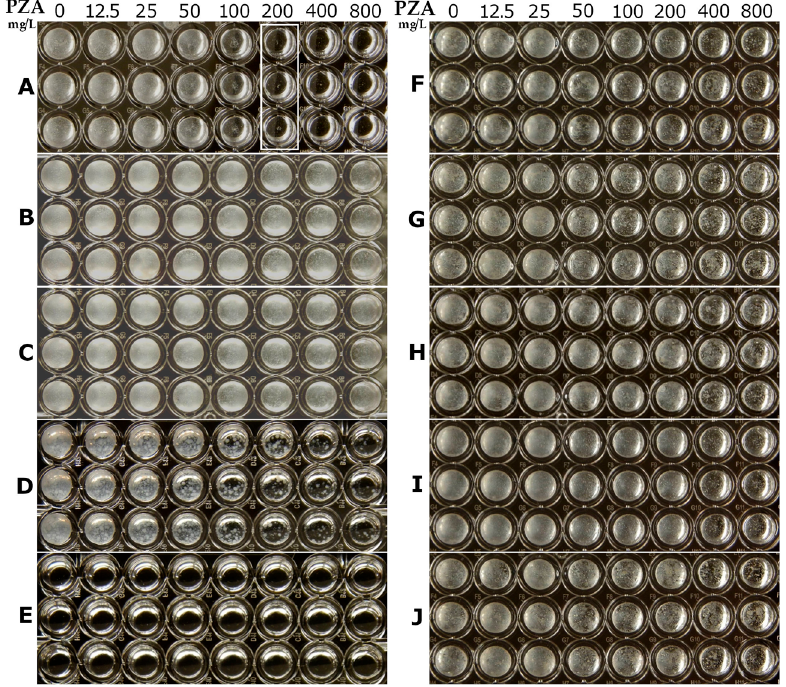
Figure 2. Determination of MIC of PZA against different M. tuberculosis strains using the broth microdilution method. ( A ), M. tuberculosis H37Ra, PZA-susceptible strain at pH 6.8 in PZA-S1 minimal medium; ( B ), M. tuberculosis H37Ra, PZA-susceptible strain at pH 6.8 in Sauton’s medium; ( C ), M. tuberculosis H37Ra, PZA-susceptible strain at pH 6.8 in Middlebrook 7H9 medium; ( D ), M. tuberculosis H37Ra, PZA-susceptible strain at pH 5.9 in Middlebrook 7H9 medium; ( E ), M. tuberculosis H37Ra, PZA-susceptible strain at pH 5.5 in Middlebrook 7H9 medium; ( F ), M. tuberculosis H37Ra PZA R #6 strain (PncA mutation L159P) at pH 6.8 in PZA-S1 minimal medium; ( G ), M. tuberculosis H37Ra PZA R #78 strain (PncA mutation C138R) at pH 6.8 in PZA-S1 minimal medium; ( H ), M. tuberculosis H37Ra PZA R #98 strain (PncA mutation W68R) at pH 6.8 in PZA-S1 minimal medium; ( I ), M. tuberculosis H37Ra PZA R #106 strain (PncA mutation D49G) at pH 6.8 in PZA-S1 minimal medium; ( J ), M. tuberculosis H37Ra PZA R #186 strain (PncA mutation G132A) at pH 6.8 in PZA-S1 minimal medium.